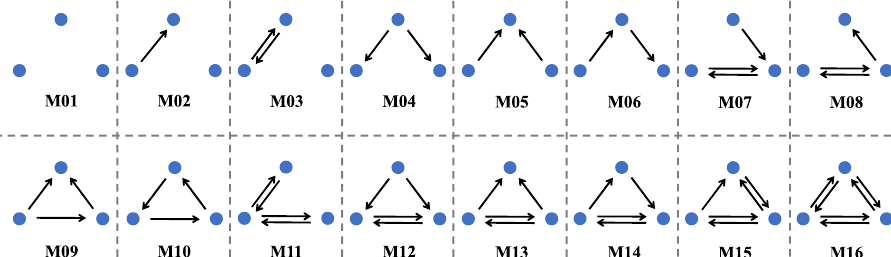
Figure 8. All possible interaction modes among the three nodes in the directed network.